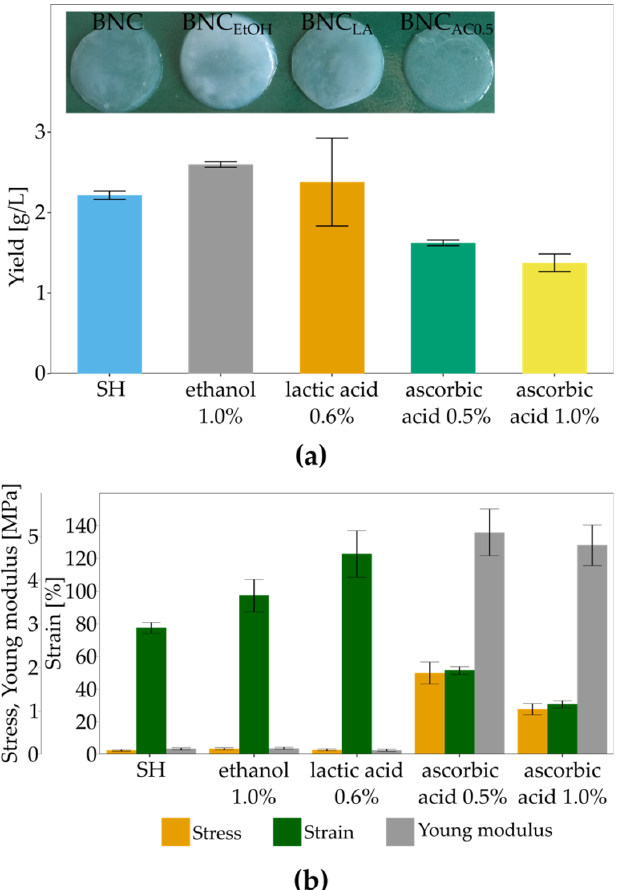
Figure 7. Impact of different culture enhancers on ( a ) BNC yield and ( b ) mechanical properties; error bars represent standard deviation.